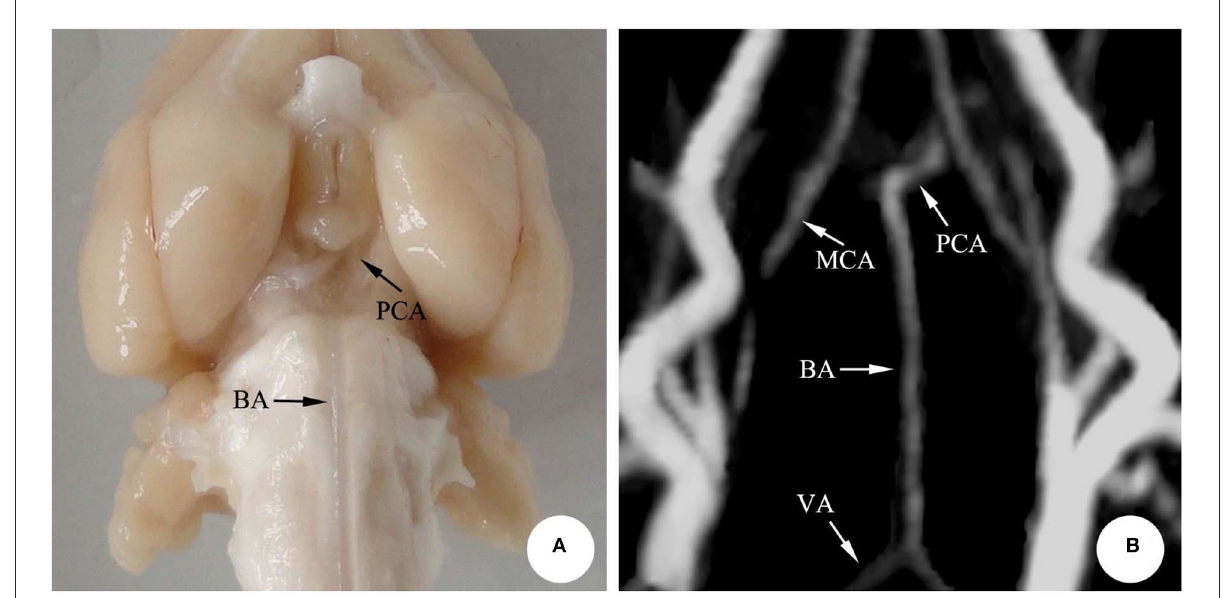
FIGURE1 The basilar artery in rabbit brain. (A) Microscopic anatomy; (B) 3D-TOF-MRA. BA, Basilar artery; PCA, Posterior cerebral artery; VA, Vertebral artery; MCA, Middle cerebral artery.